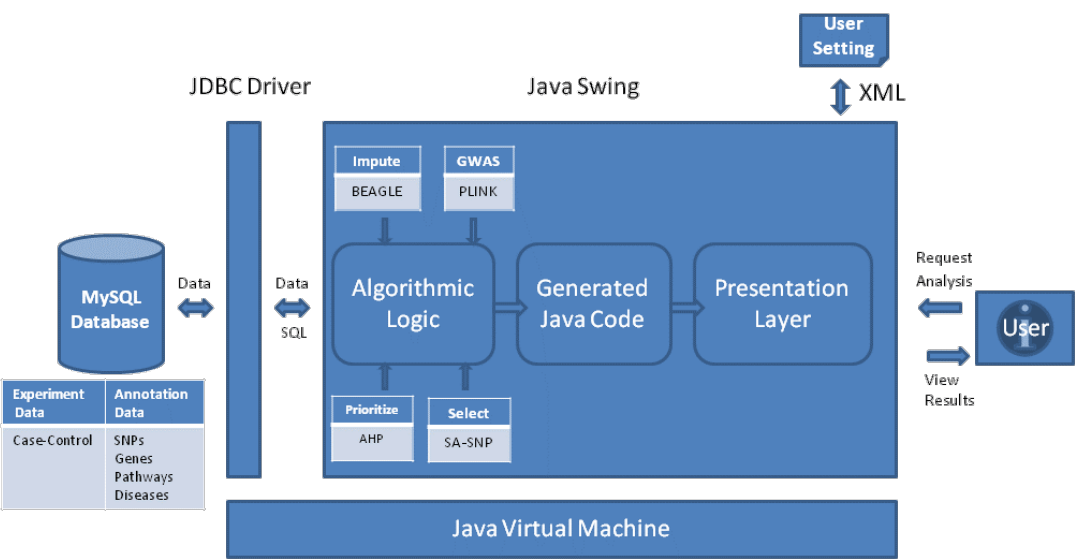
Figure 3: System architecture for